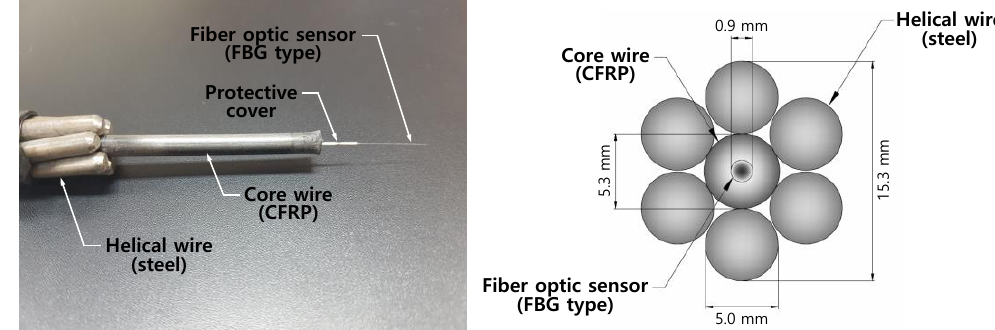
Figure 1. Configuration of a Smart Strand.